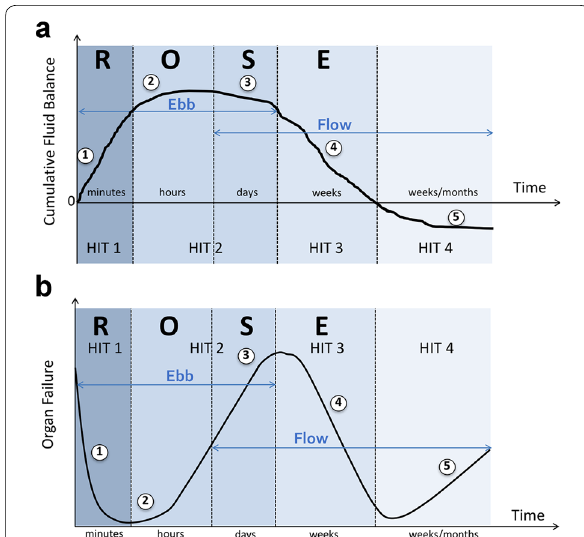
Fig. 5 The different fluid phases during shock. Adapted from Mal‑ brain et al. with permission [1]. a Graph showing the four‑hit model of shock with ebb and flow phases and evolution of patients’ cumula‑ tive fluid volume status over time during the five distinct phases of resuscitation: resuscitation (1), optimization (2), stabilization (3) and evacuation (4) (ROSE), followed by a possible risk of Hypoperfusion (5) in case of too aggressive de‑resuscitation. See text for explanation. b Graph illustrating the four‑hit model of shock corresponding to the impact on end‑organ function in relation to the fluid status. On admission patients are hypovolemic (1), followed by normovolemia (2) after fluid resuscitation, and fluid overload (3), again followed by a phase going to normovolemia with de‑resuscitation (4) and hypov‑ olemia with risk of hypoperfusion (5). In case of hypovolemia (phases 1 and 5), O 2 cannot get into the tissues because of convective prob‑ lems, in case of hypervolemia (phase 3) O 2 cannot get into the tissue because of diffusion problems related to interstitial and pulmonary oedema, gut oedema (ileus and abdominal hypertension). See text for